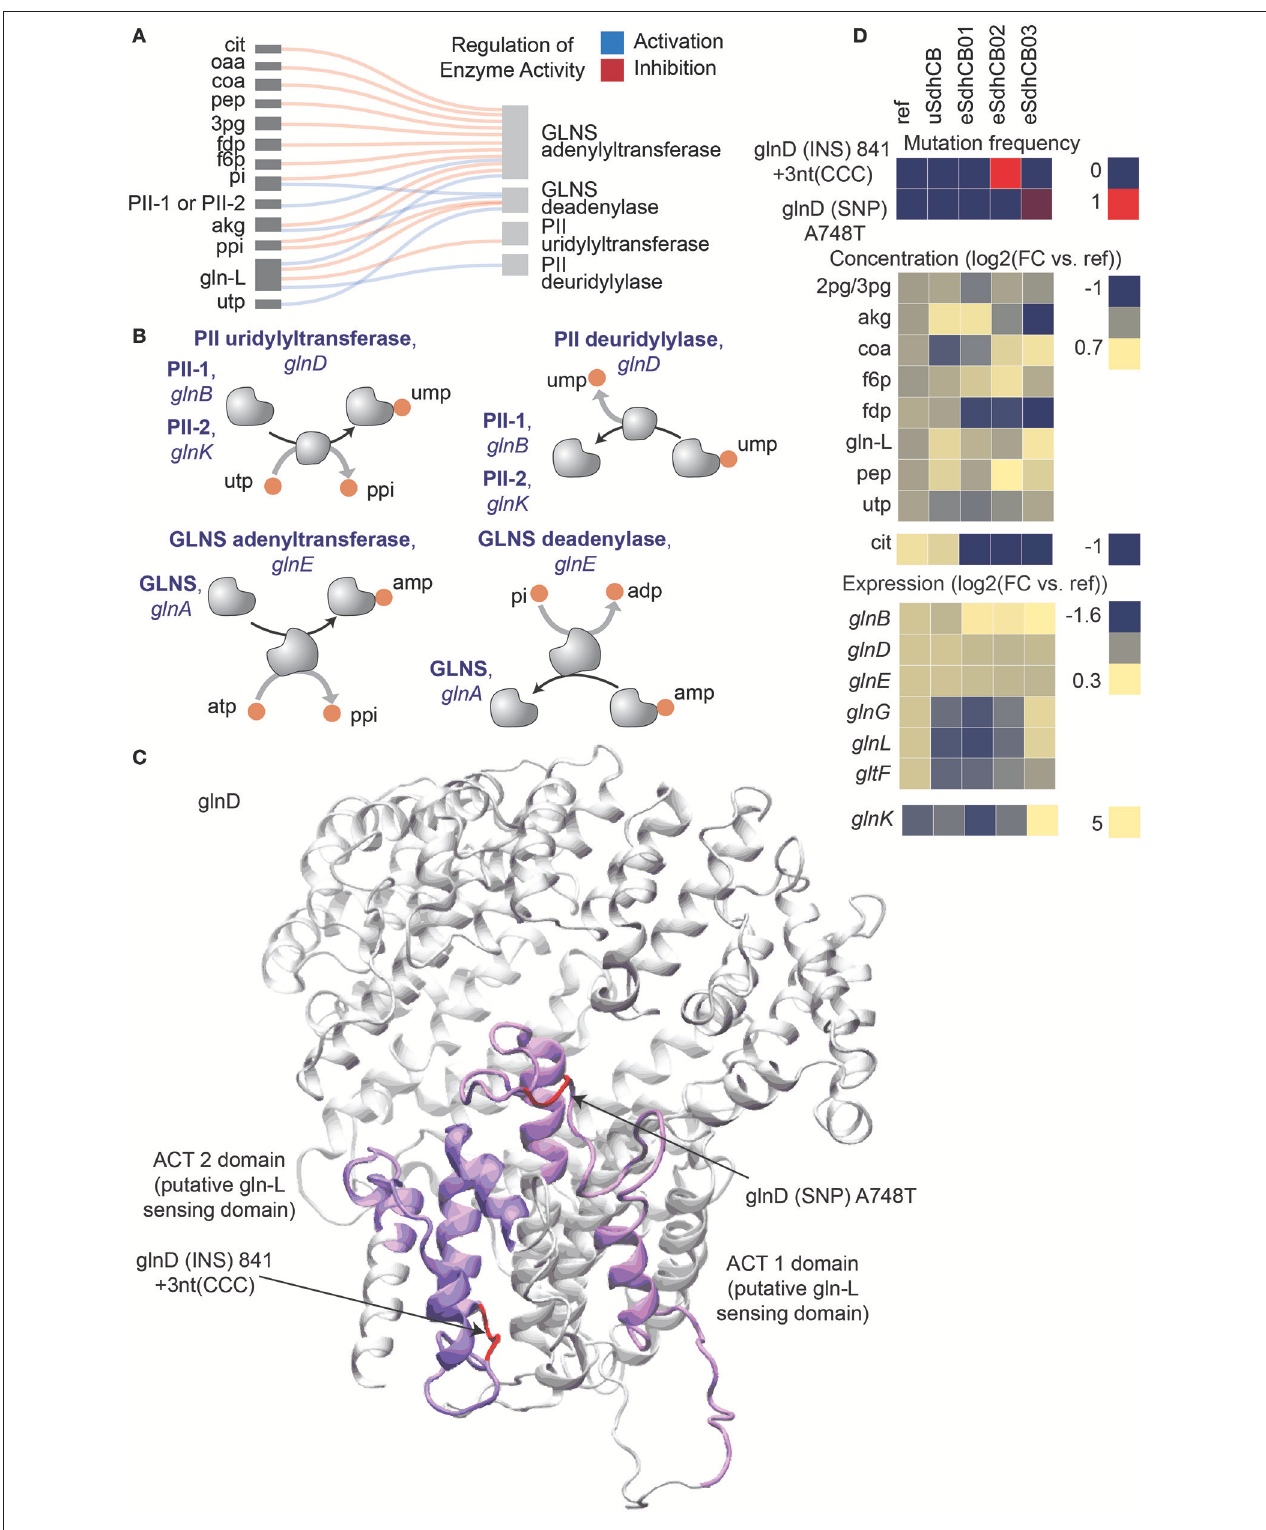
FIGURE 6 | Mutations that potentially affect regulation of nitrogen assimilation in eSdhCB strains. Mutations in glnD , which encodes the primary nitrogen status sensor PII uridylyl-/deuridylyl-transferase, fixed in eSdhCB02 and overtook a majority of the population in eSdhCB03. (A) Regulatory diagram of allosteric